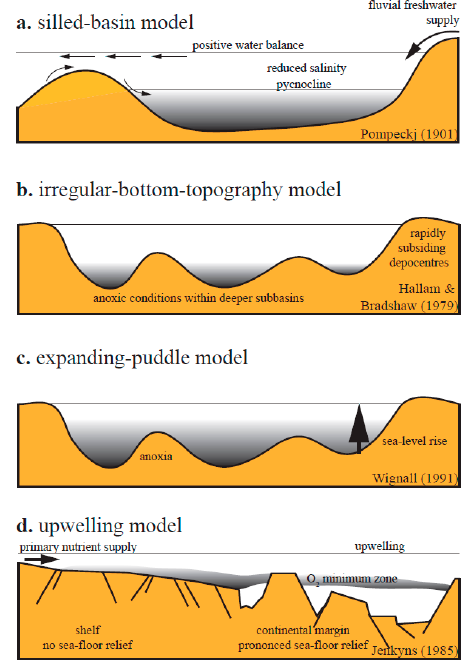
Figure 1. Theoretical models of organic-rich deposit conditions; ( a ) The silled-basin model is inspired from the Black Sea setting. The water stratification due to fresh water supply with reduced salinity allows the development of anoxia in the bottom layer [24]; ( b ) In the irregular bottom topography model, the anoxia is led by low water circulation within the deep sub-basins which are created by rapidly subsiding depocenters [15]; ( c ) The expanding puddle model is driven by the development of an anoxic layer in the deepest and confined part of the basin. The layer spreads during transgressive period and allows the preservation of organic matter [17]; ( d ) In the upwelling model, the anoxia is initiated by a high primary productivity which led to the expansion of an oxygen minimum zone [16] (figure after Röhl and Schmid-Röhl